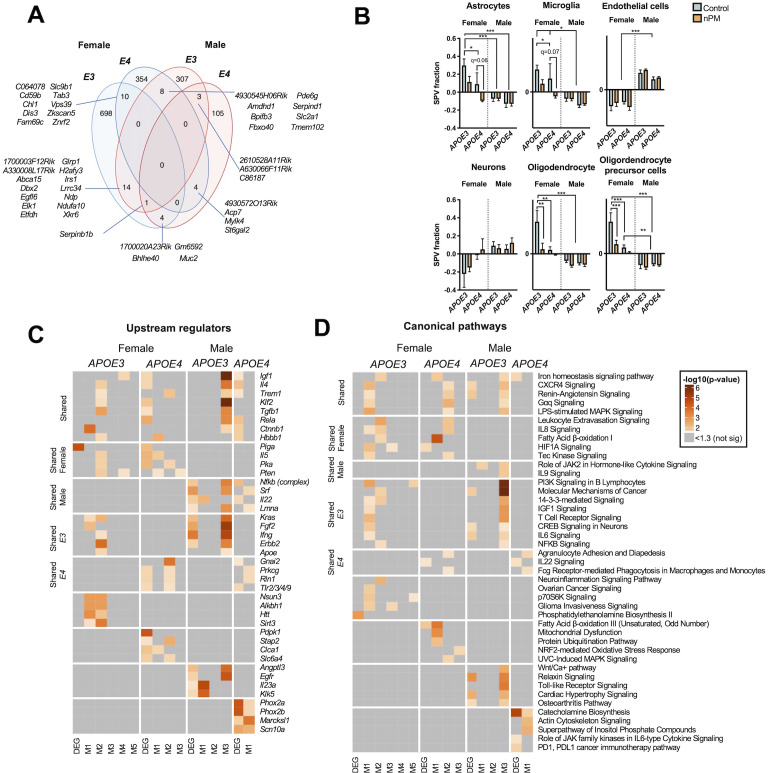
nPM associated changes in male and female APOE-TR mouse.(A) Venn diagram of the nPM DEGs in each group. (B) Brain RNAseq cell type deconvolution using BRETIGEA package in R. (C) Top upstream regulators and (D) canonical pathways of nPM associated genes in ApoE-TR mouse.